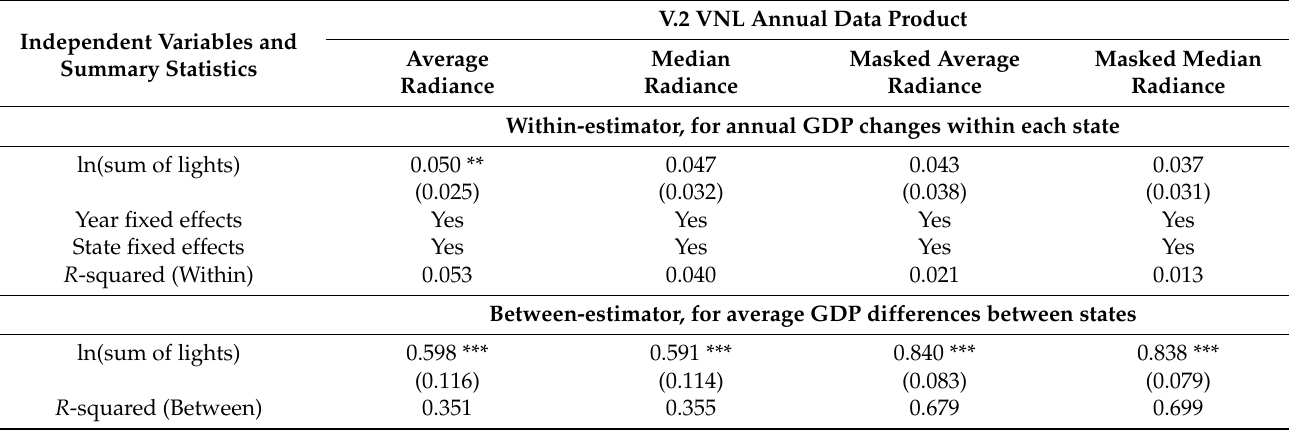
Table 3. Relationships between VIIRS V.2 NTL and state-level GDP: within and between estimator results. Independent Variables